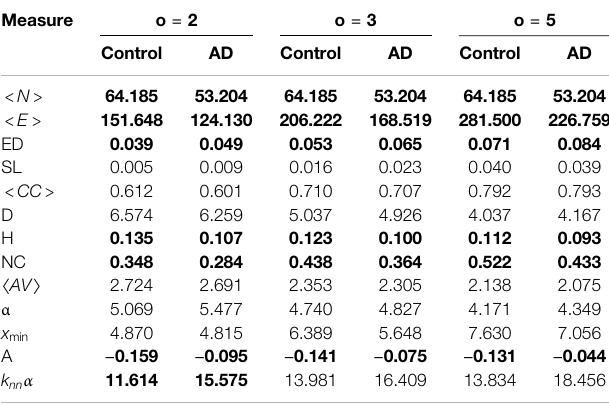
TABLE 1 | Means for the network measures for each dataset. Bold font indicates the mean difference is signi fi cant between the AD and controls for that co- occurrence window at p < 0 . 05 level. The parameter o refers to the size of the co- occurrence window.